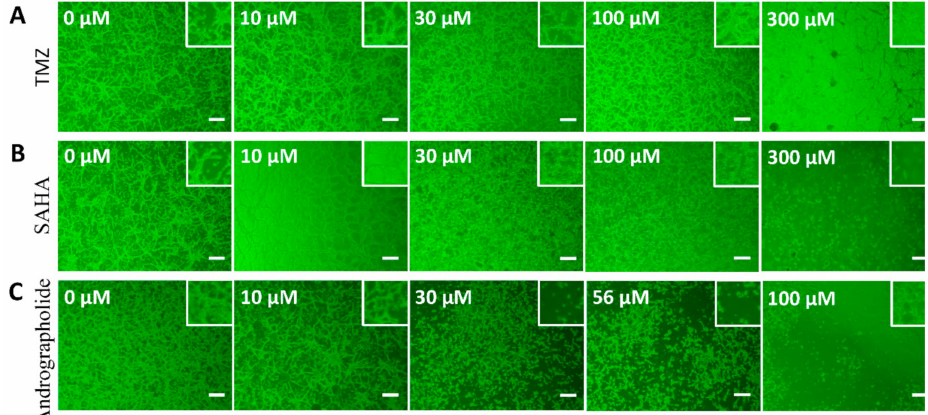
Figure 1. Cytotoxic e ff ects of drug treatment on U-87 MG cells. Phase-contrast images reveal cell morphology at 24 h after drug induction and are compared with those of drug-free cell controls. ( A ) Treatment with 10, 30, 100, and 300 µ M TMZ; ( B ) 10, 30, 100, and 300 µ M SAHA; ( C ) 10, 30, 56, and 100 µ M andrographolide. A concentration-dependent decrease was observed after cells were treated with a higher concentration of each drug. Scale bar = 200 µ